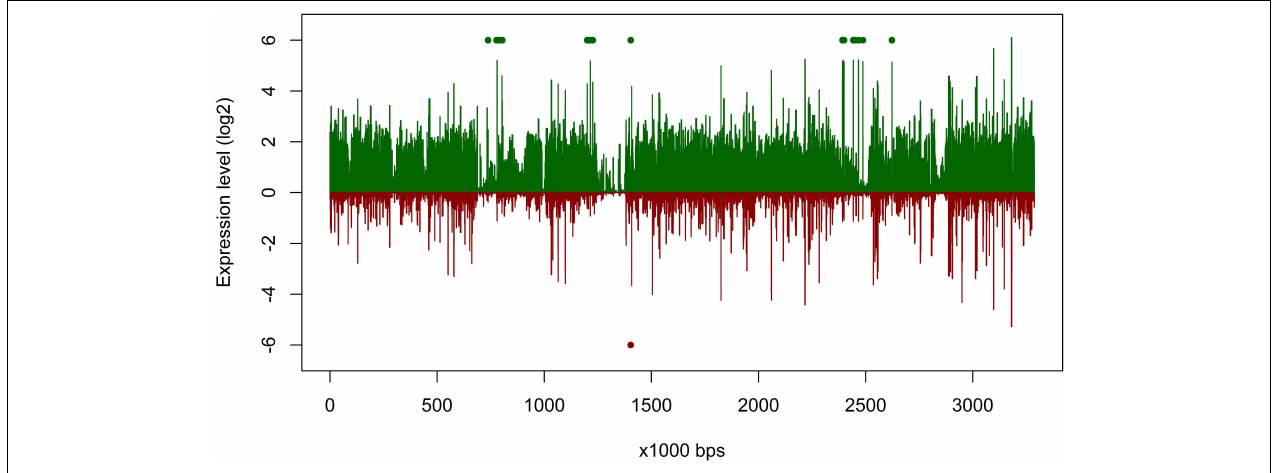
FIGURE 4 | Gene expression of Planktomarina temperata RCA 23 inside and outside the examined phytoplankton bloom. Gene expressions are log2 transformed mean values from the three non-bloom and six bloom stations, respectively. To obtain only positive values,